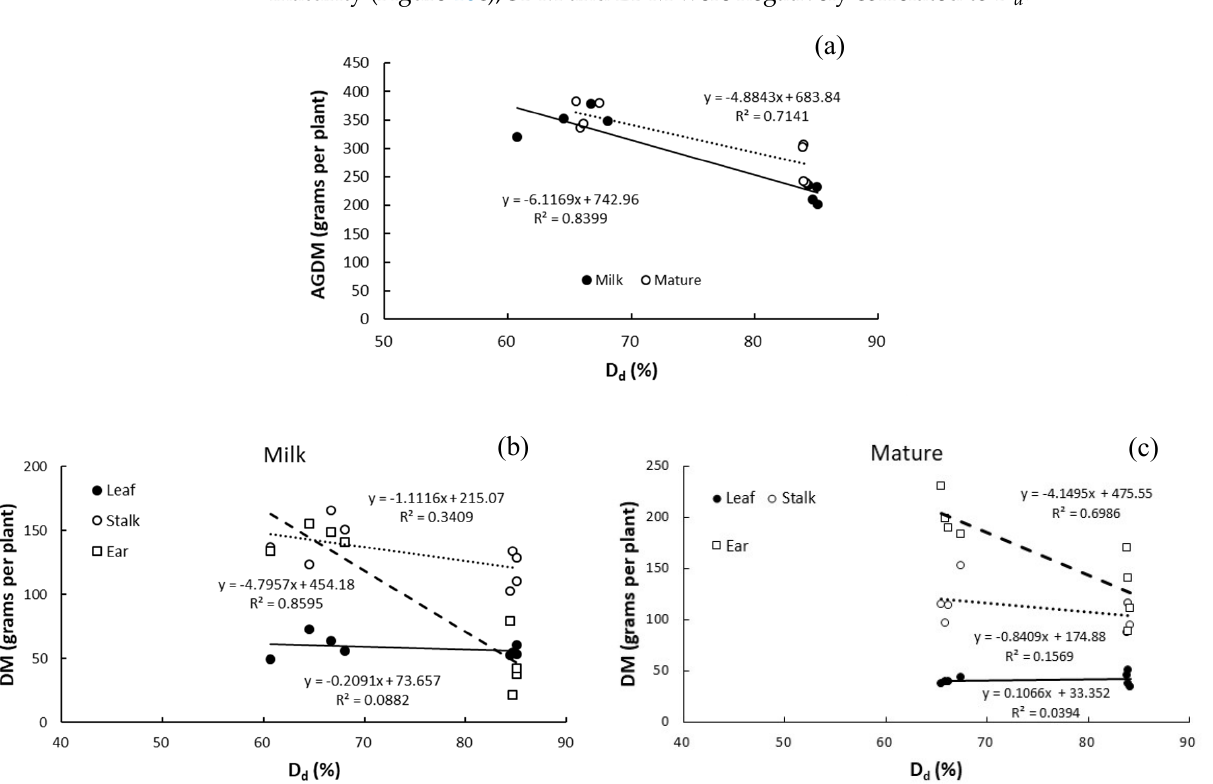
Figure 10. Correlations between dry matter of leaves, stalk, or ears of maize and degree of drought at the milk stage and at maturity: ( a ) the relationship between D d and AGDM, ( b ) the relationship at milk stage, ( c ) the relationship at maturity.